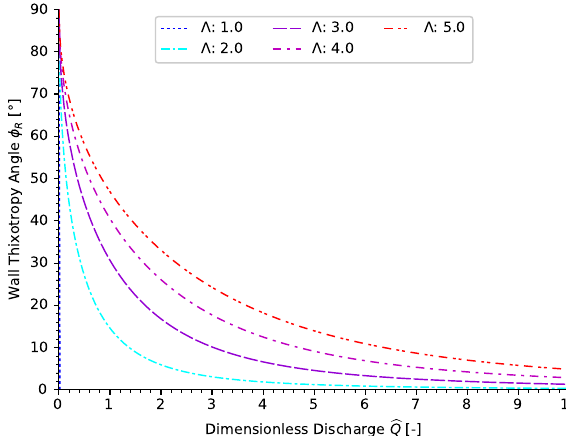
Figure 10: By an alternative interpretation through the thixotropy angle ϕ R it can also be observed that the influence of thixotropy fades exponentially for higher discharges and lower thixotropy factors Λ